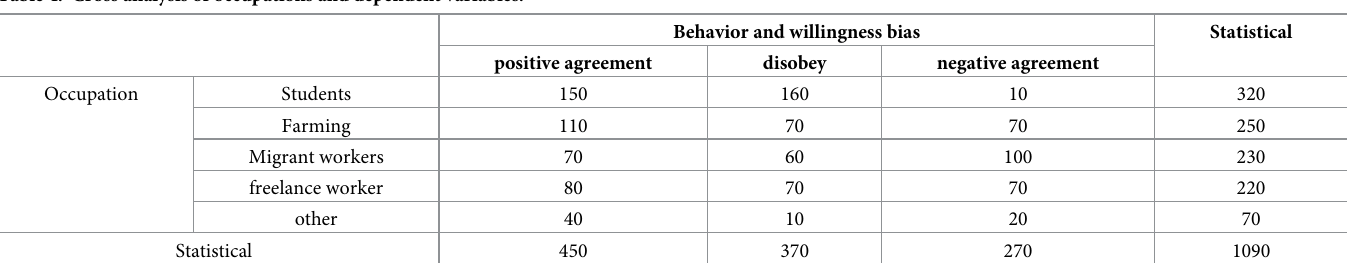
Table 4. Cross analysis of occupations and dependent variables.